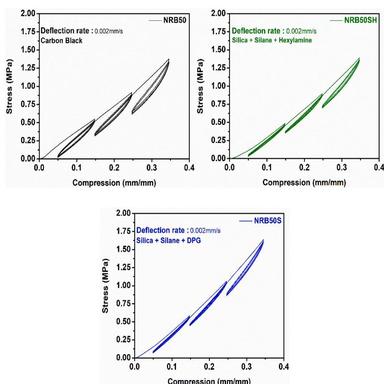
Stress-stain relationship obtained from the cyclic test shown in.